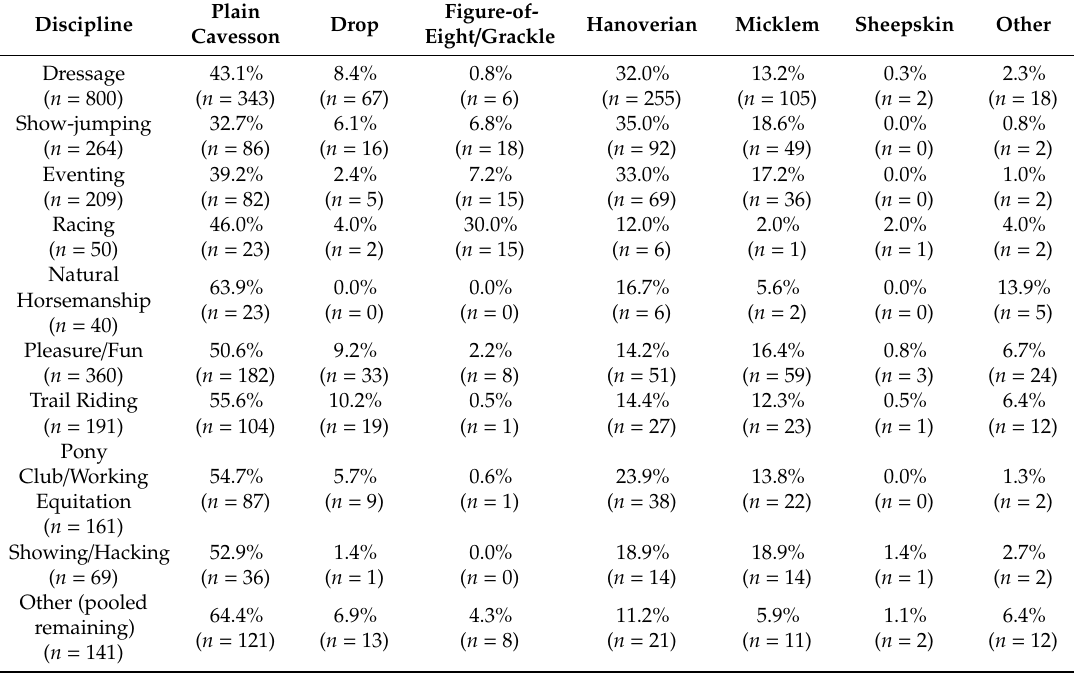
Table 4. Distribution of each type of noseband across each discipline with at least 40 respondents (total n = 2316). The numbers in each cell represent the overall distribution of the type of noseband (columns) within each respective discipline (rows). “Other” categories include Driving, Endurance, Western, Polo / Polocrosse, Hunting, Mounted Games / Horseball and Mustering / Farm